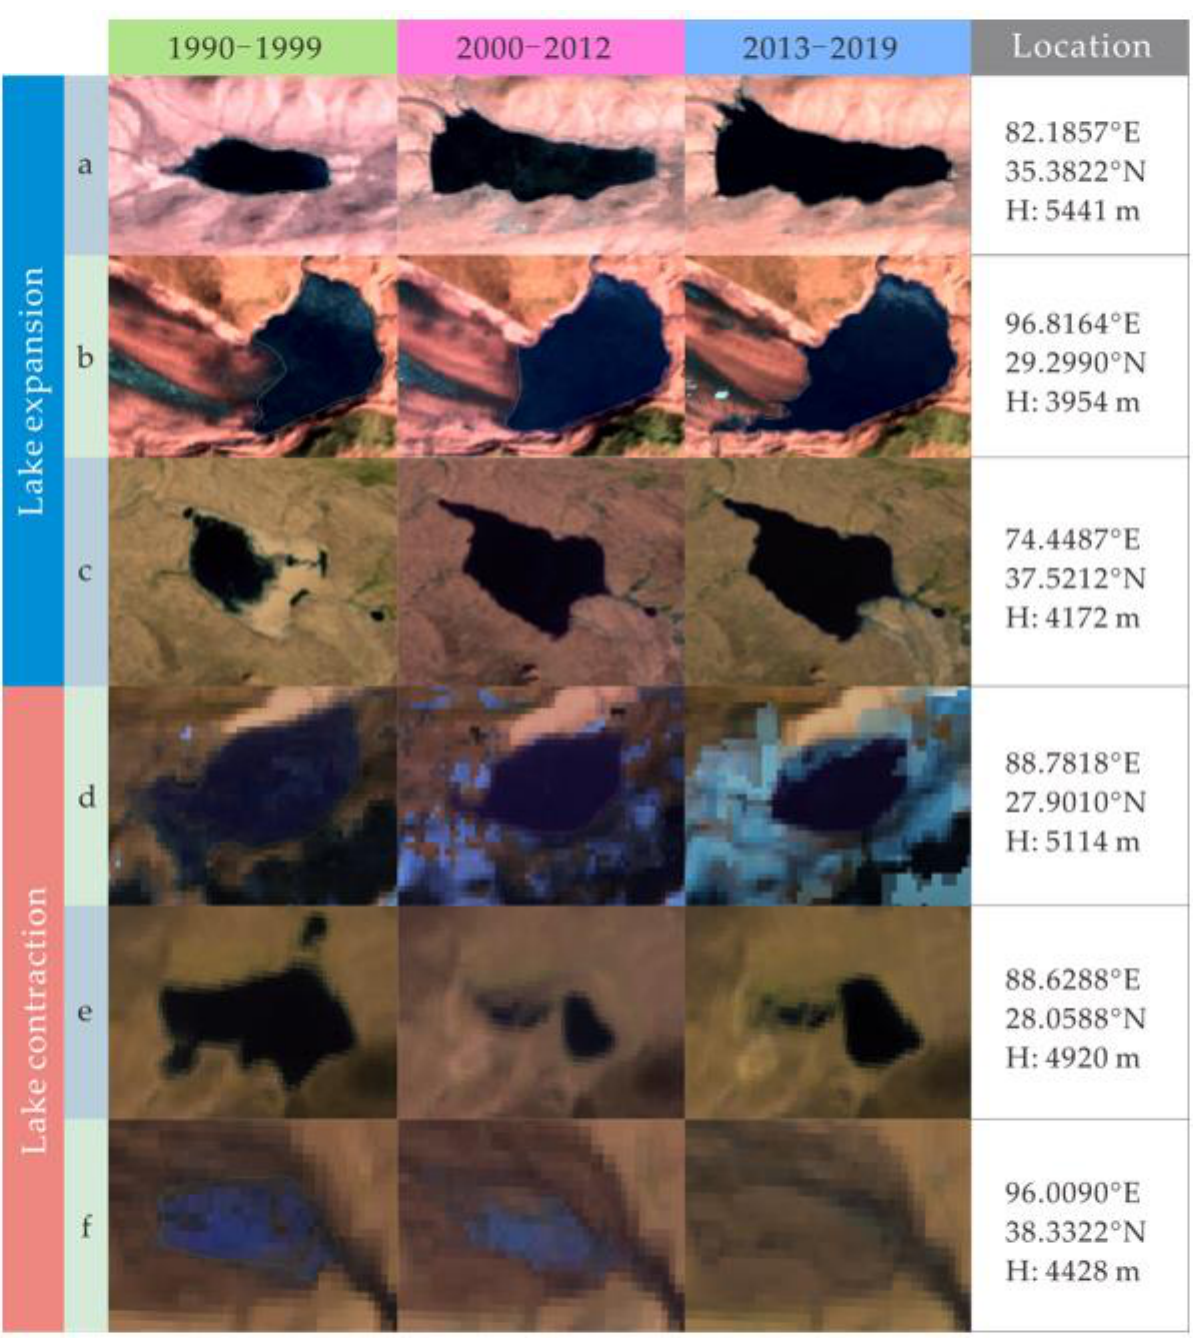
Figure 6. ( a – f ) Examples of glacial lake expansion and contraction, the location was the approximate latitude and longitude and the height of the lake ’ s center. The scale of all three images within each grouping is consistent. Background imageries were obtained from Landsat satellite images preprocessed by GEE (for automatic extraction, see Section 3.1).